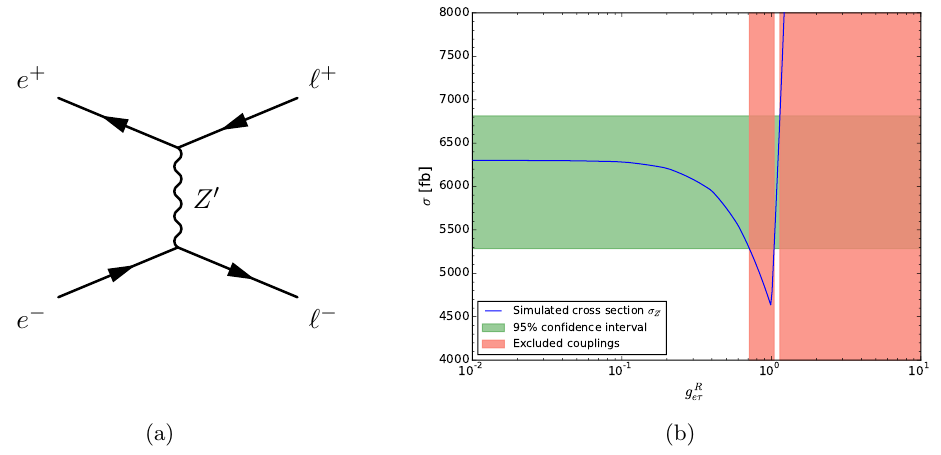
Figure 16 . (Left) Tree-level dilepton production via Z 0 at LEP, where ‘ is either the (cid:22) or the (cid:28) . (Right) The blue curve is the total simulated cross section (cid:27) Z 0 for the process e + e (cid:0) ! (cid:28) + (cid:28) (cid:0) at p s = 207 GeV. The green band depicts the 95% con(cid:12)dence interval of the measured cross section (cid:27) exp . The red area shows the excluded couplings g R e(cid:28)